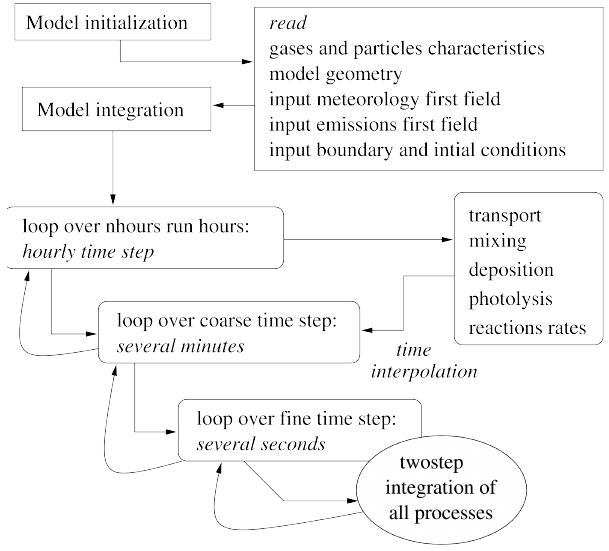
Fig. 2. General CHIMERE structure for time integration of all pro- cesses